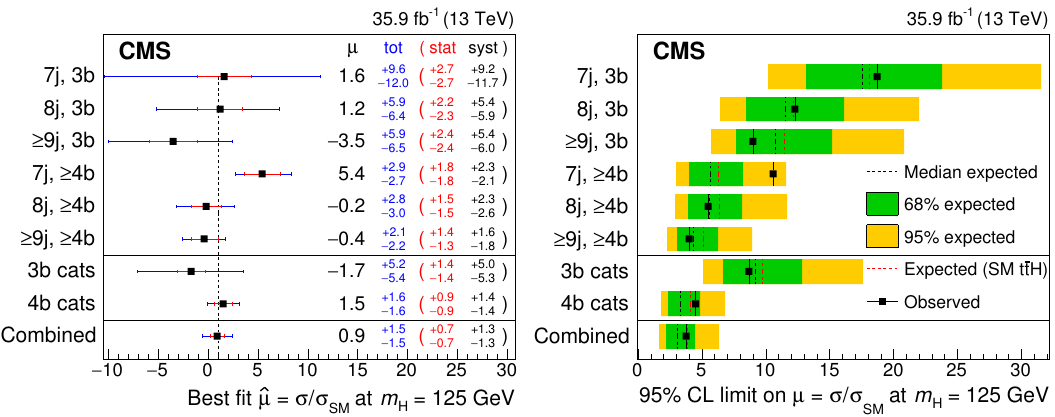
Figure 7 . Best (cid:12)t values in the signal strength modi(cid:12)ers ^ (cid:22) , and their 68% CL intervals as split into the statistical and systematic components (left), and median expected and observed 95% CL upper limits on (cid:22) (right). The expected limits are displayed with their 68% and 95% CL intervals, as well as with the expectation for an injected SM signal of (cid:22) = 1.